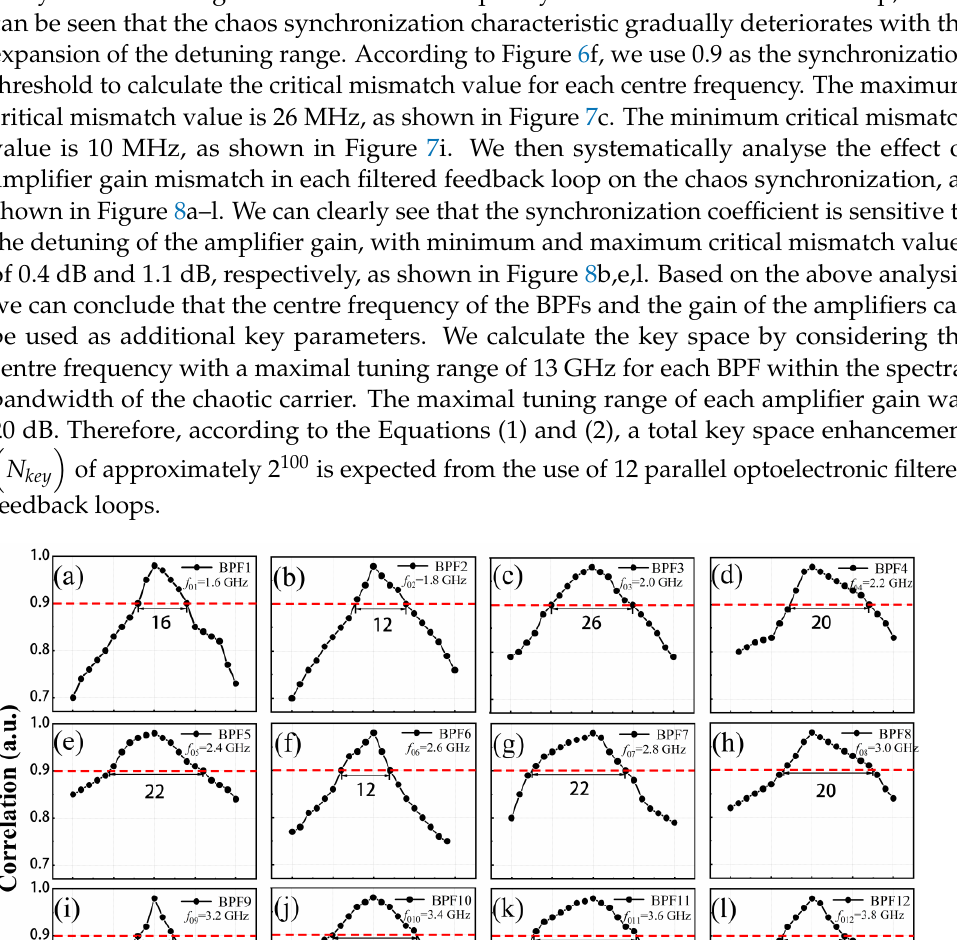
Figure 8. Effects of mismatch of amplifier gain on correlation coefficient. (a)-(l) The gain of ampli- fier is 20 dB. 4. Discussion Key space enhancement is significantly pursued for high-level security communica- tion. In this paper, we propose and simulate a scheme of key space enhanced chaotic se- cure communication based on spectrum-programmable optoelectronic feedback. From Figures 7 and 8, we can conclude that the synchronization coefficients are sensitive to the detuning of centre frequencies of the filters and the amplifier gains in the feedback loop. Thus, the centre frequencies of the filters and the gains of the RF amplifiers can be used as additional physical keys of the system to enhance the key space. The simulation results suggest that the proposed scheme can reach a huge key space. In principle, with the in- crease in the parallel number, the key space will be further enhanced. A tuneable BPF with a frequency response range of 2–18 GHz, a bandwidth of 4 GHz (ADMV8818, ADI) and a variable-gain RF amplifier with a gain range of 18–36 dB (ADL5246, ADI) can be applied